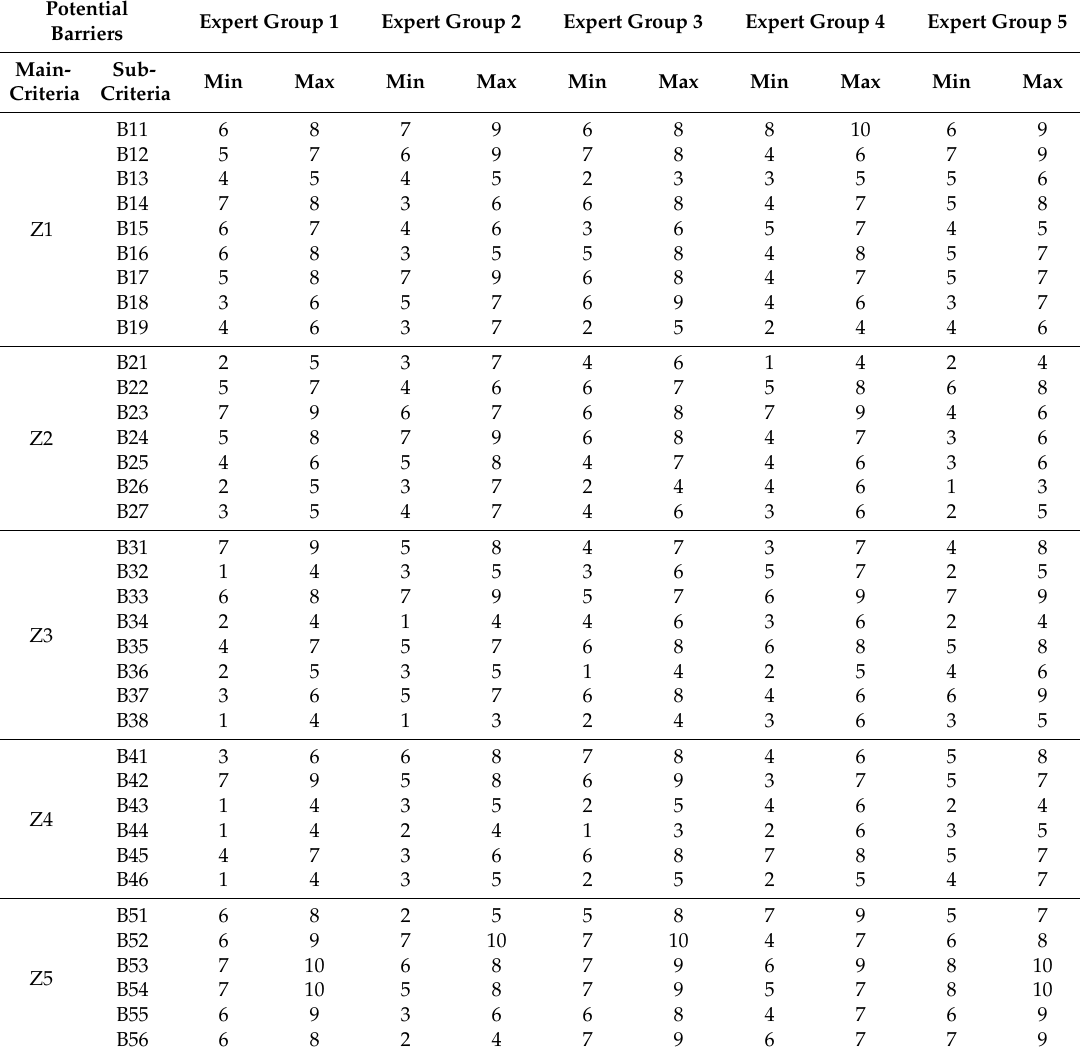
Table 5. Sub-criteria relative importance given by the five expert